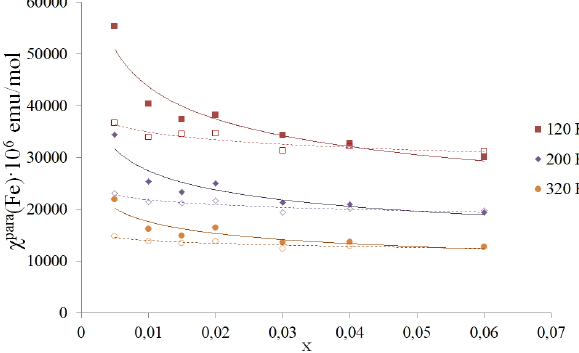
Figure 4: A compassion between paramagnetic components of magnetic susceptibility for Bi 2 Mg 1− x Fe x Nb 2 O 9+ δ (open symbols) and Bi 2 MgNb 2−2 x Fe 2 x O 9− δ (close symbols) solid solutions